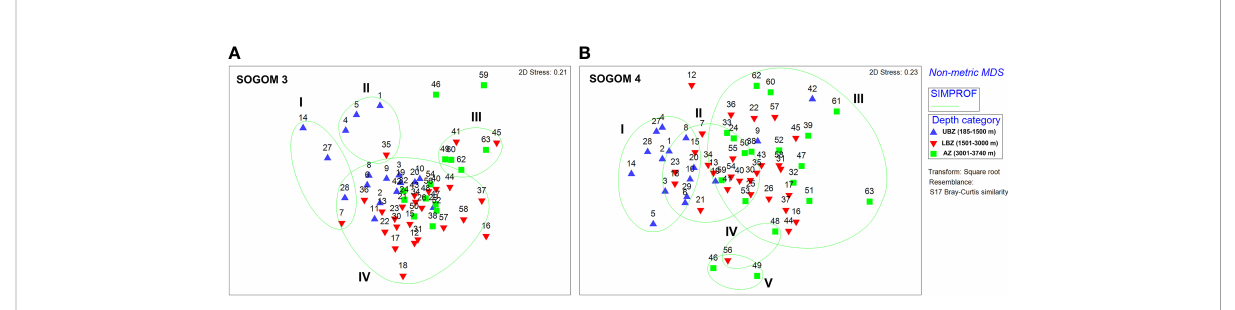
FIGURE 9 Non-metric multidimensional scaling of macrofauna communities of SOGOM 3 (A) and SOGOM 4 (B) with a classi fi cation analysis plotted (green line) based on Bray Curtis similarities. Upper bathyal zone (UBZ-blue triangles), lower bathyal zone (LBZ-red inverted triangles), and abyssal zone (AZ-green square).